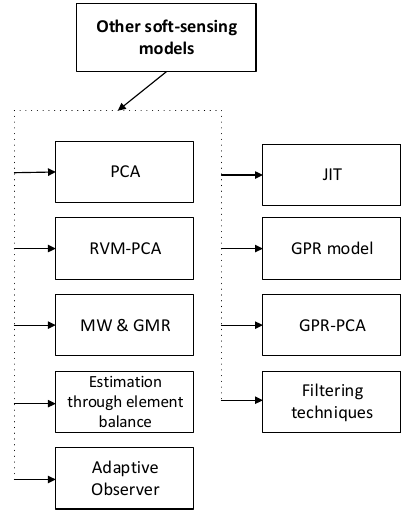
Figure 8. Some other useful methods (abbreviations are listed in Table A1).